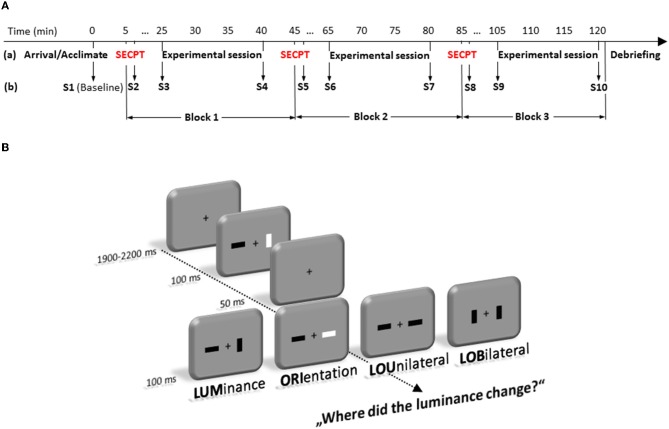
Time-line (in minute) of the experimental protocol (A). It depicts the sequence of stress and experimental test sessions (a) as well as the 10 time points where saliva samples (S1–S10) were taken (b). (B) represents the experimental paradigm. Participants had to detect changes in luminance of a bar in a fast sequence of frames that could occur alone (LUM), accompanied by a change in orientation of the same bar (LOU), accompanied by an orientation change at the opposite location (LOB). Trials in which only the orientation (ORI) changed at a single bar were no-go trials.